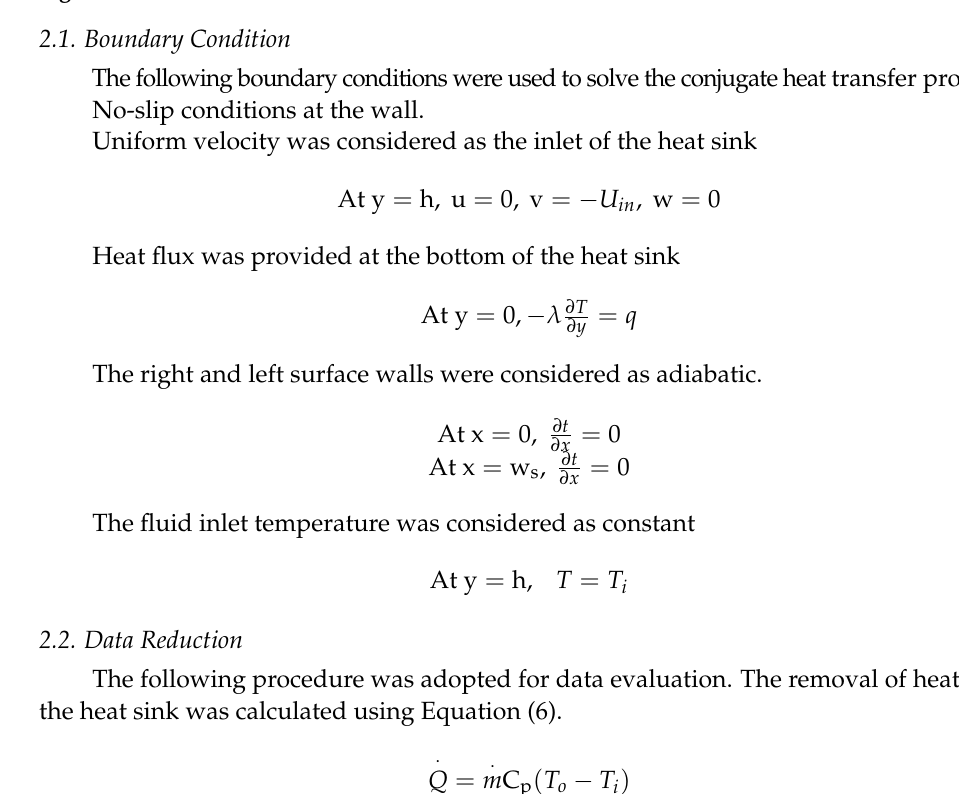
Figure 1. Validation of numerical